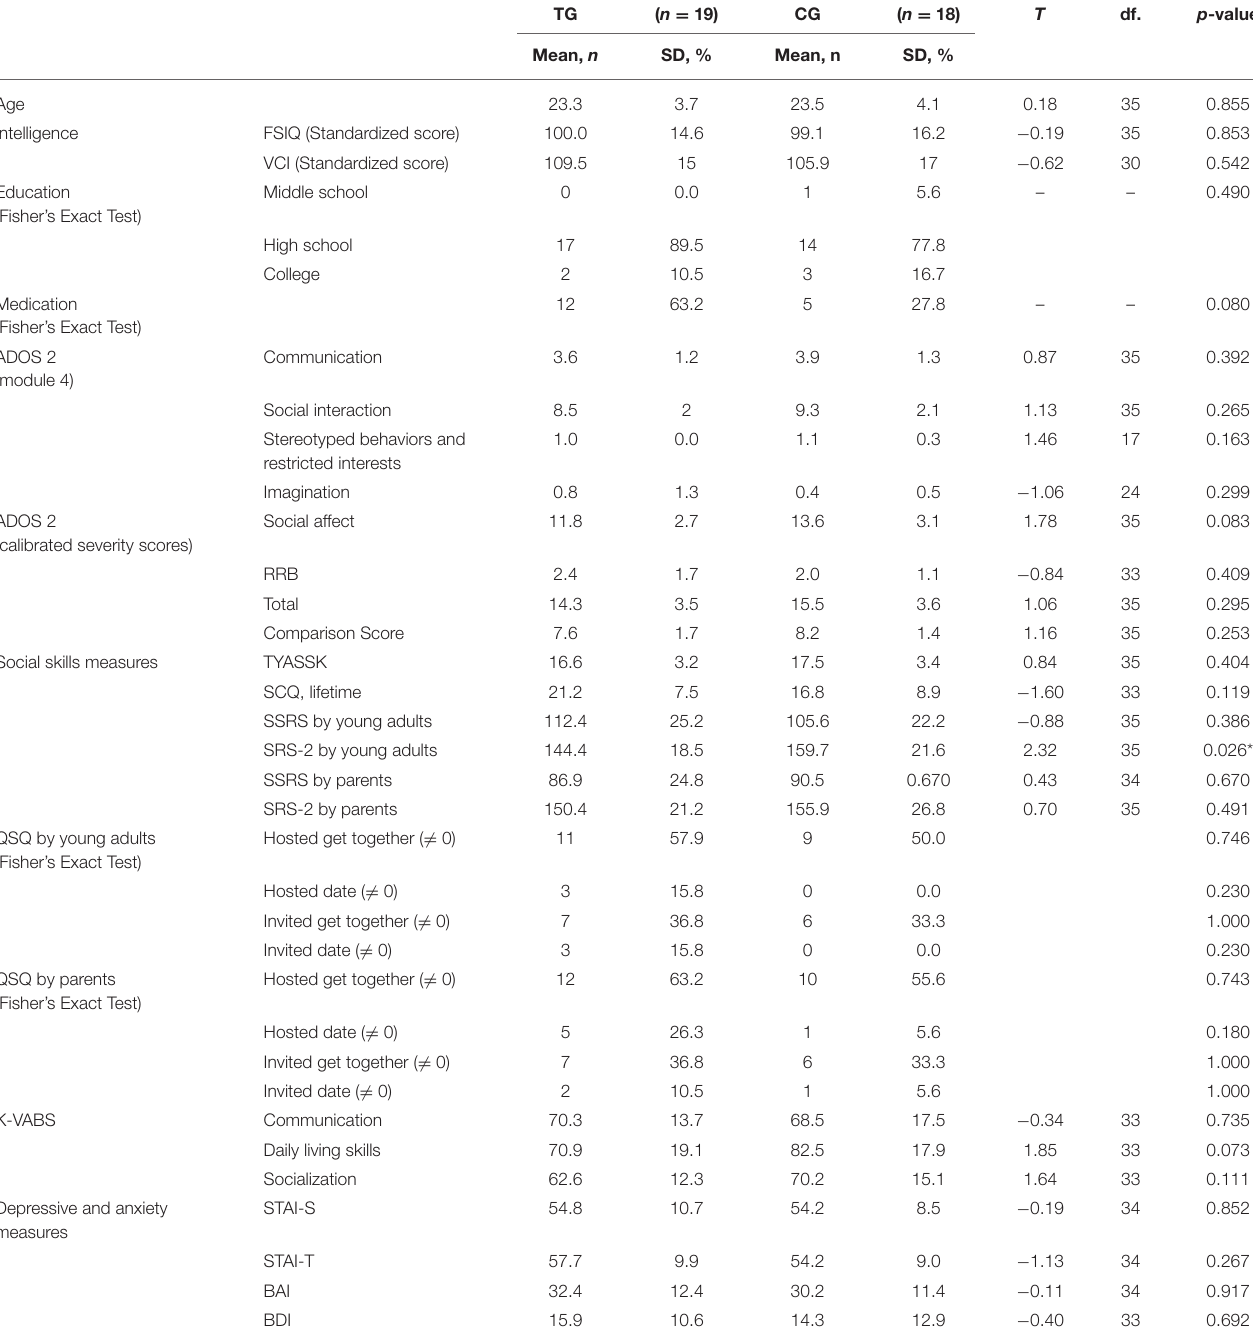
TABLE 1 | Mean demographic and baseline